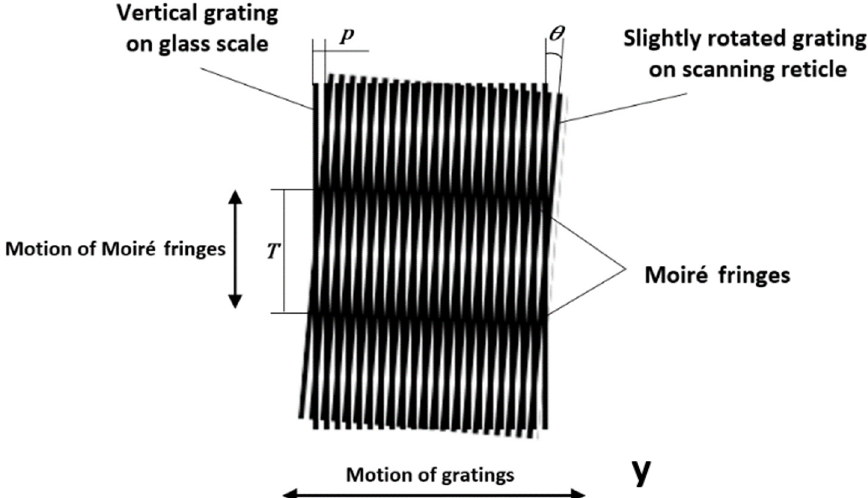
Figure 3. Superposition of the two slightly rotated gratings and the formation of Moiré